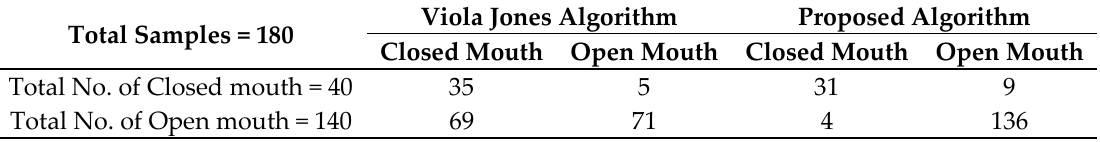
Table 1. Comparison of the results of Viola Jones mouth detection algorithm and the proposed algorithm.